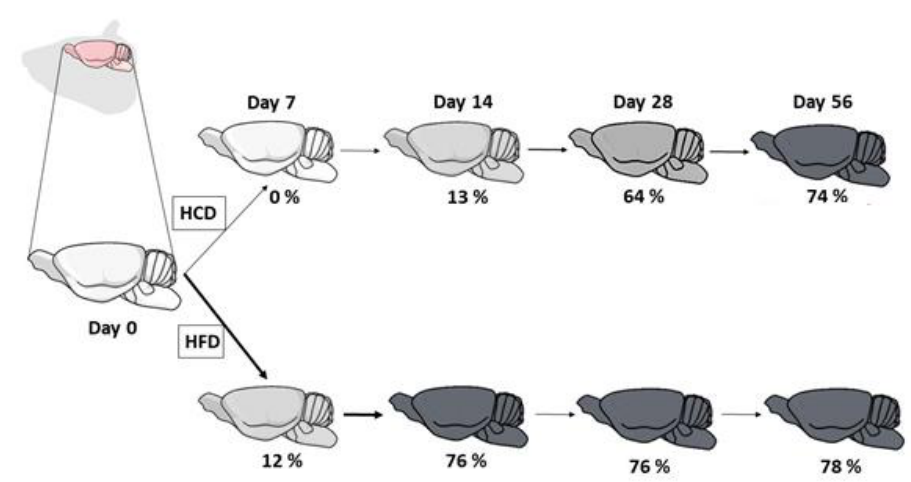
Figure 5. Summary of the results in brains of mice fed with either high carbohydrate diet (HCD) or high fat diet (HFD). The grey color indicates the intensity of fatty acid (FA) accumulation (%). Bold arrows indicate faster FA deposition. HFD exhibited an increased speed of FA deposition, however, at the end of 56 days, HFD and HCD had the same amount of brain FA content.